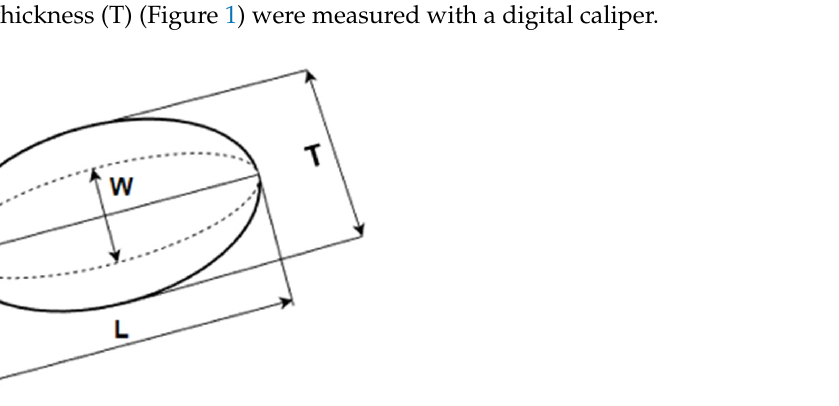
Figure 1. Representation of dimensions measured for each grain kernel: width (W), length (L), and thickness (T).